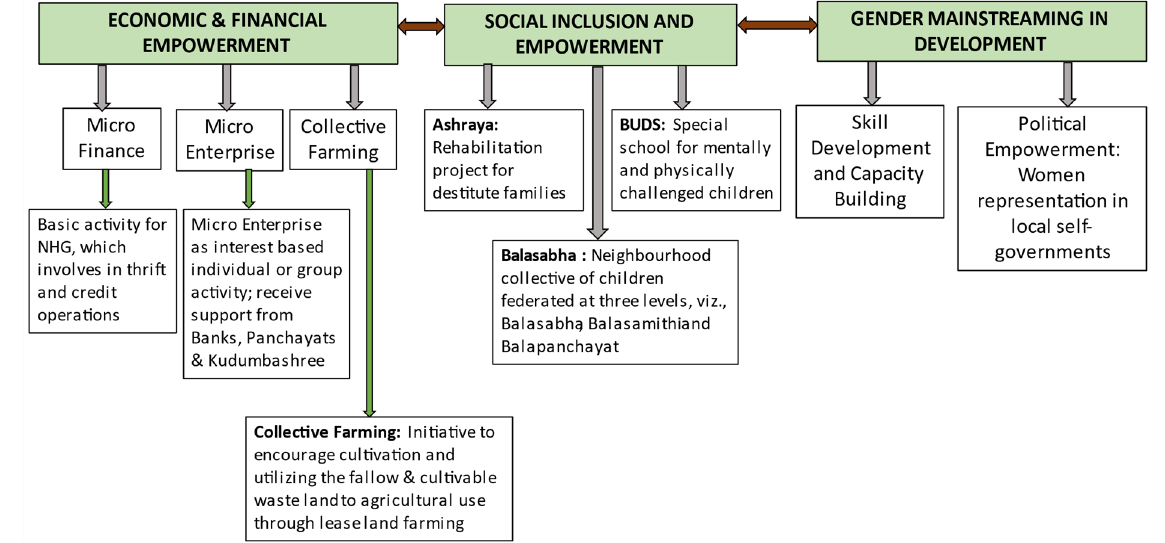
Figure 2. Kudumbashree and multi-dimensional empowerment.